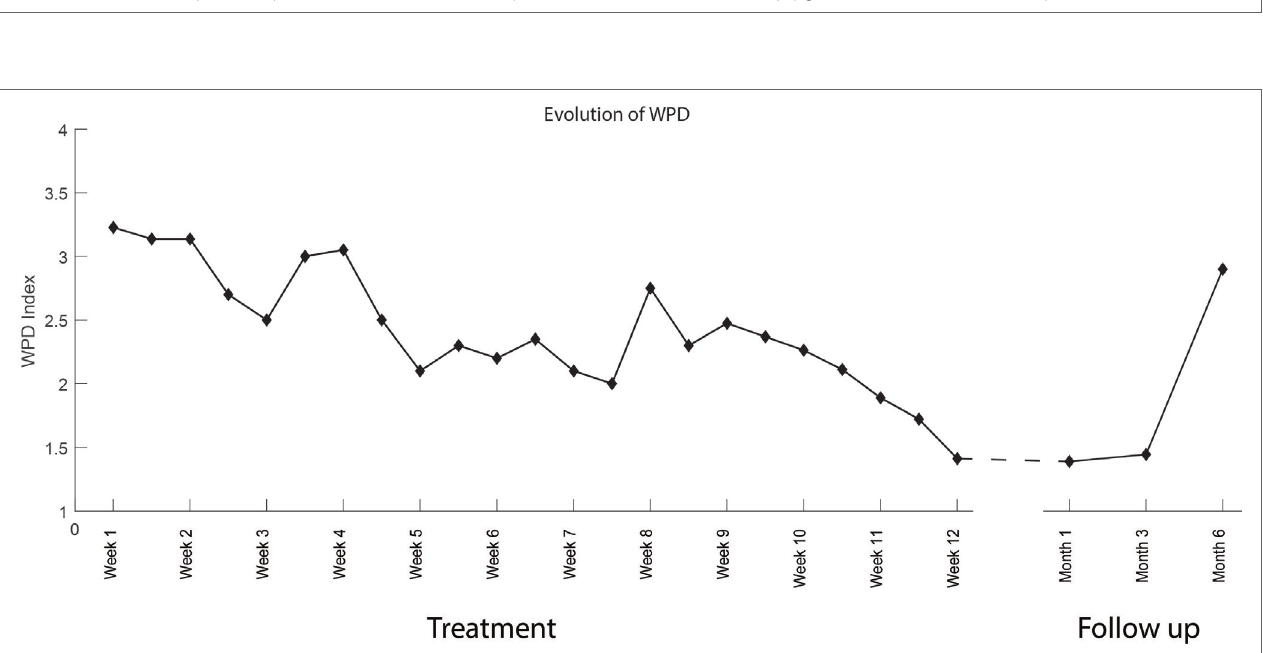
FigUre 7 | Evolution of the Pain Rating Index (PRI) over the course of the treatment and in the follow-up period (6 months). The PRI is calculated as the sum of the scores (0–5) assigned to the pain descriptors of the Short Form of the McGill Pain Questionnaire (SF-MPQ). The SF-MPQ was administered at the beginning of each treatment session twice per week (left hand side of the dashed line) and at 1, 3, and 6-month follow-up (right hand side of the dashed